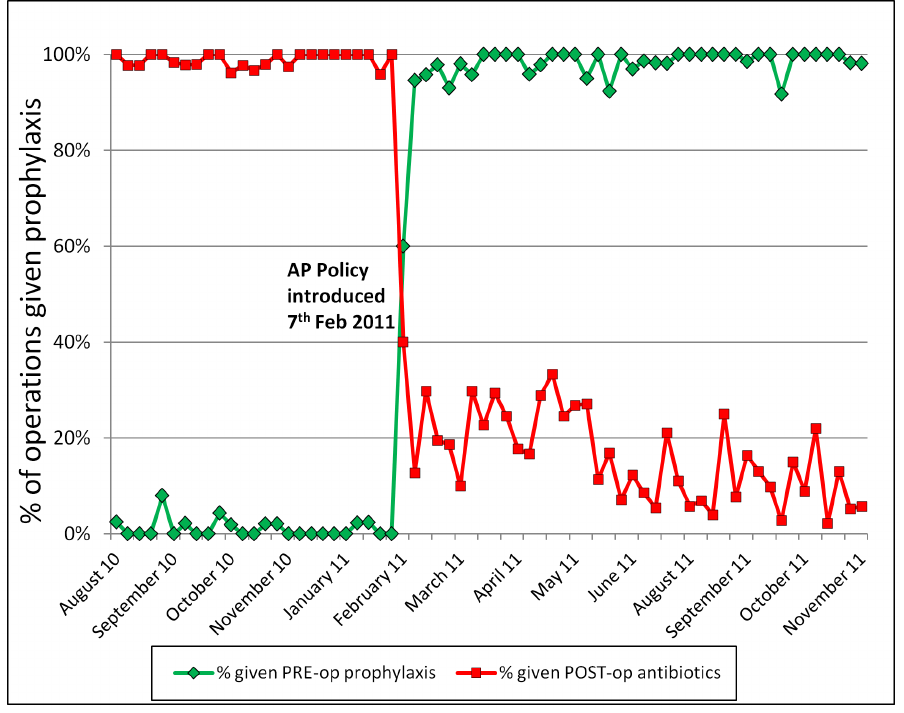
Figure 1. Weekly prescribing practices for surgical antibiotic prophylaxis.